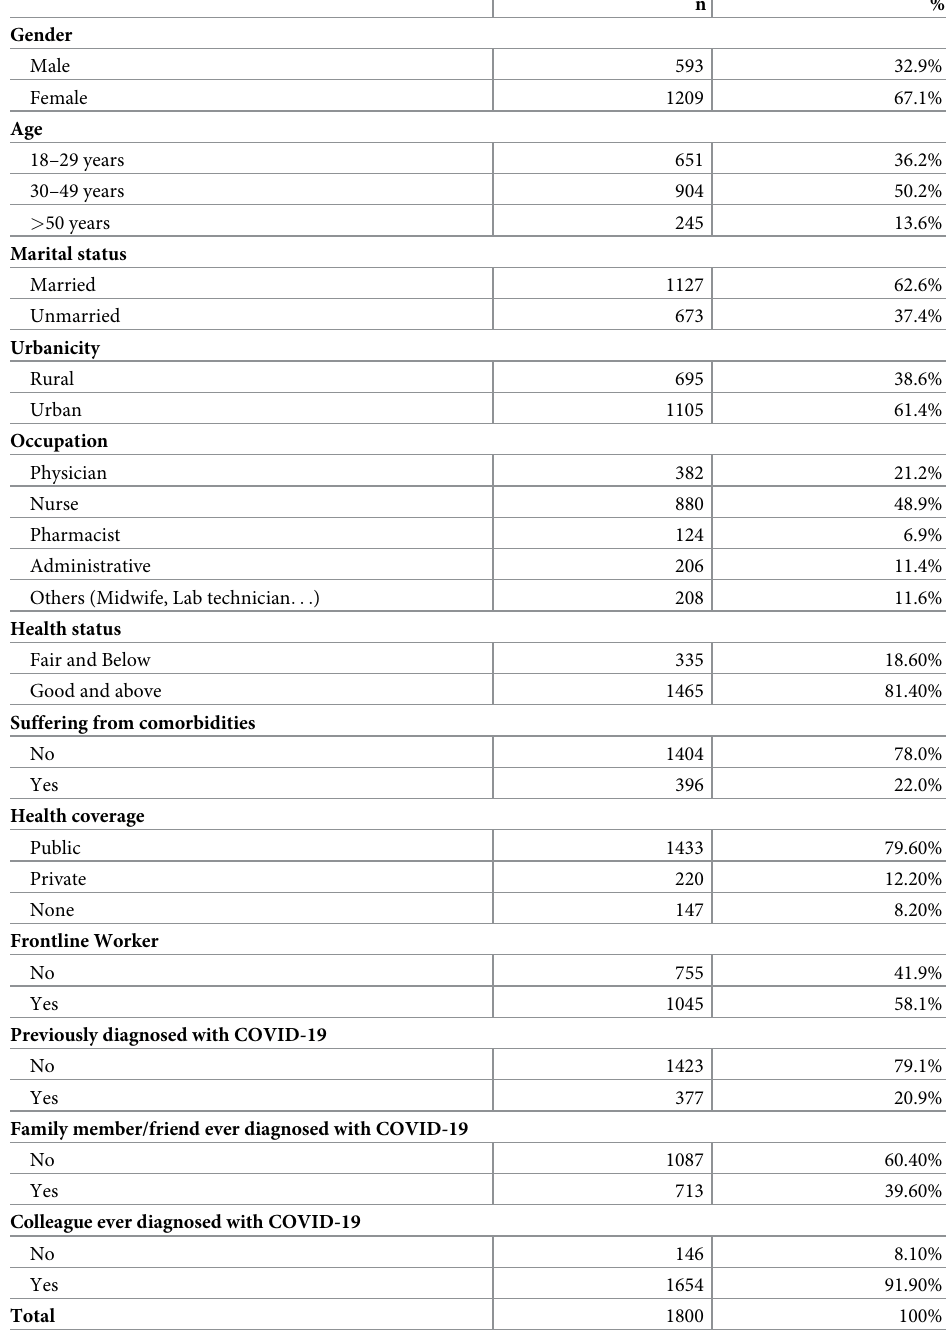
Table 1. Baseline characteristics of the participants (N =